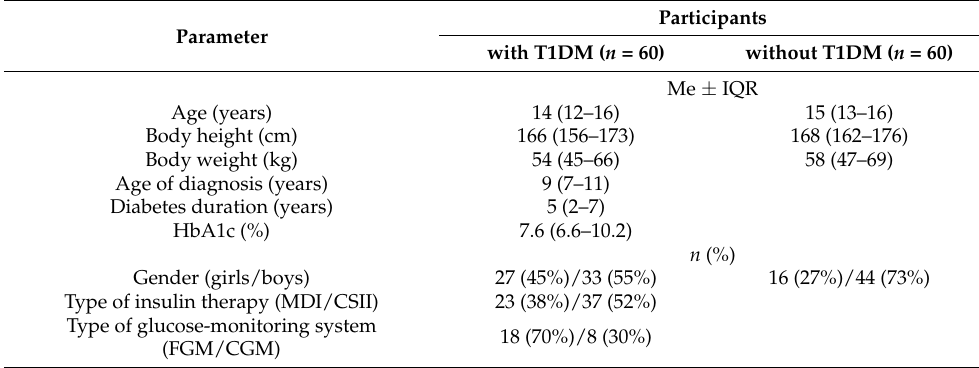
Table 2. Characteristics of the study